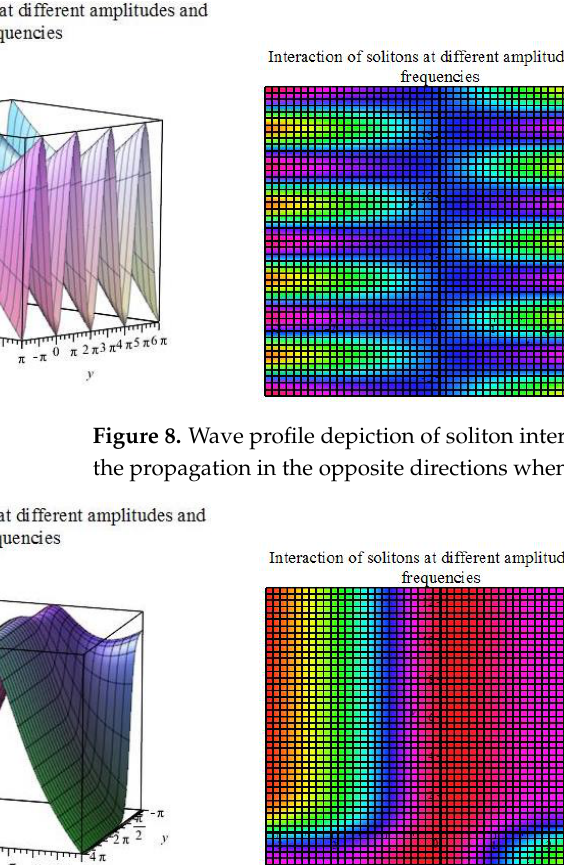
Figure 7. Wave profile depiction of soliton interaction with varying amplitudes, frequency and also propagating at different time intervals when variable x = 0.